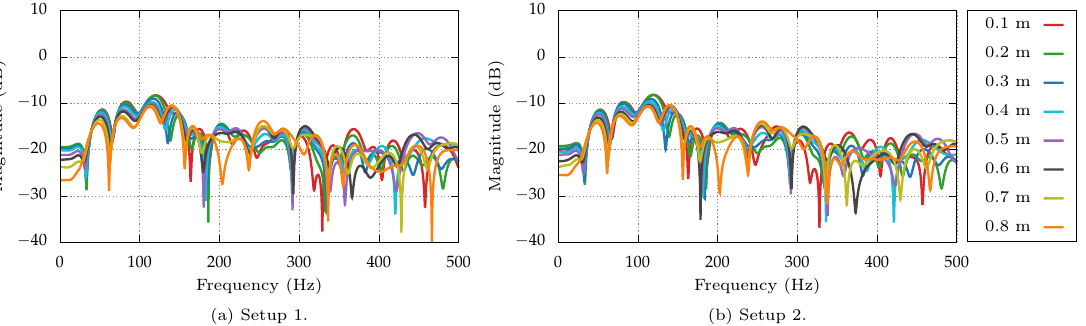
Figure 6. The amplitude functions of the frequency functions of the impulse response estimates for the paths between one of the room microphones and the primary source for the eight different distances between the active casing and the wall.